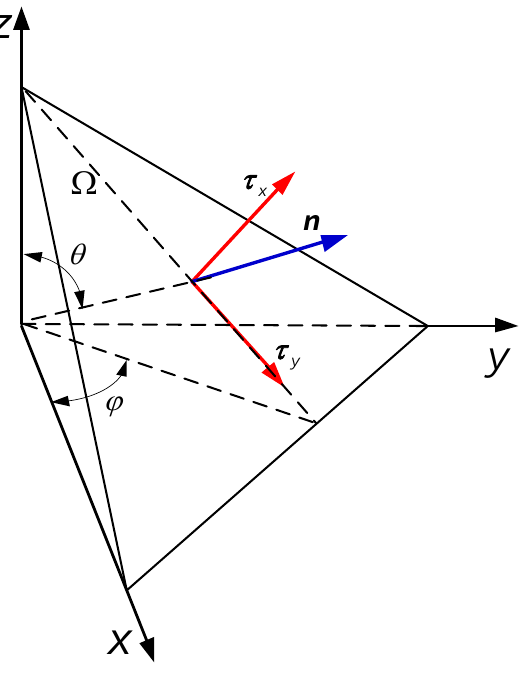
Figure 4. Spherical coordinates employed to define material plane.